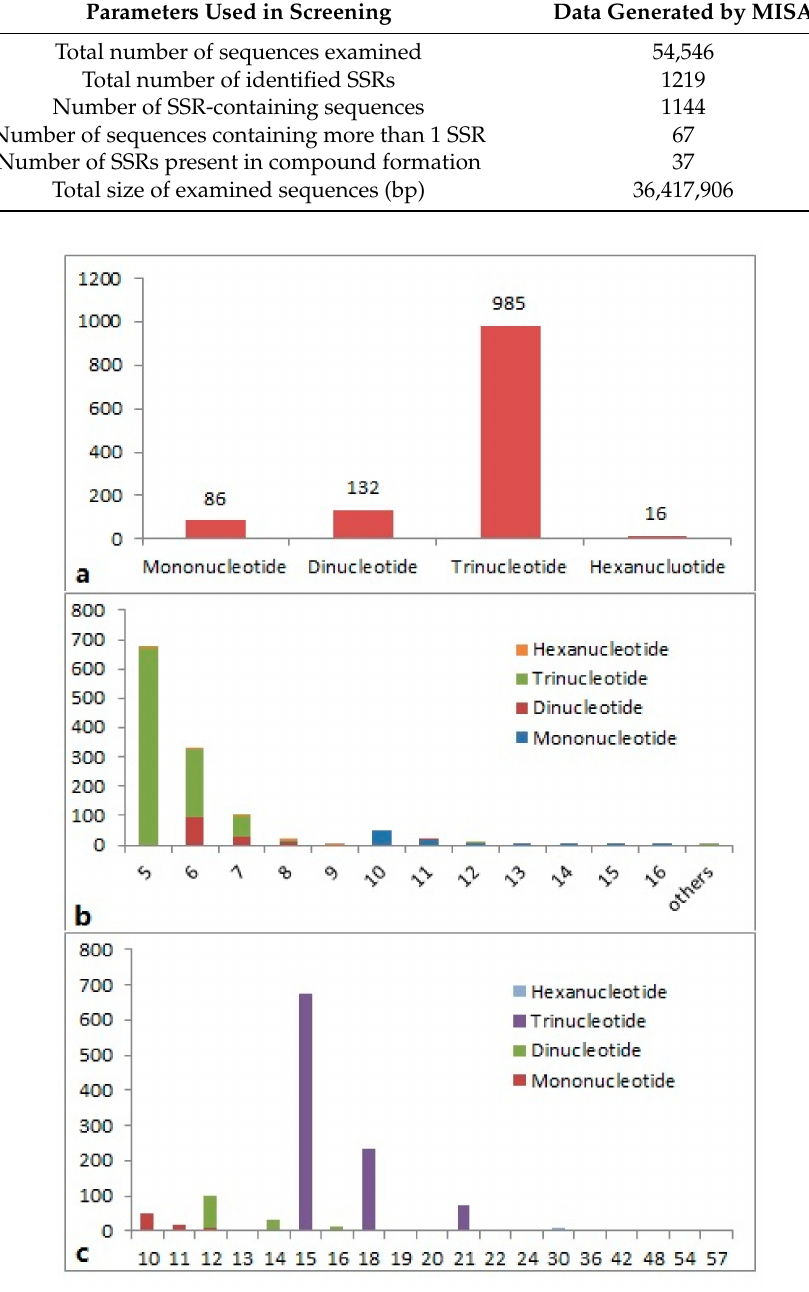
Figure 1. Frequency distribution of the putative expressed sequence tag-simple sequence repeats (EST-SSRs) from patchouli expressed sequence tags (ESTs) based on ( a ) the distribution of EST-SSRs types, ( b ) the EST-SSRs repeat number, and ( c ) the EST-SSRs’ repeat lengths